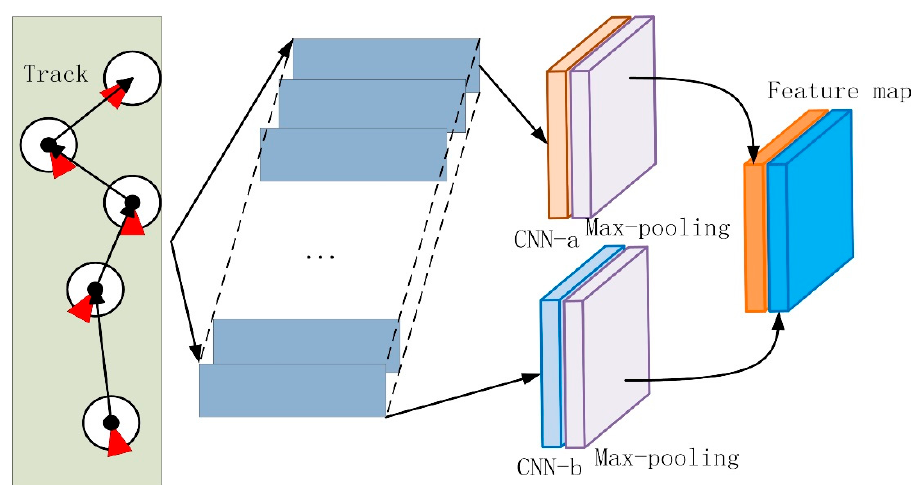
Figure 2. Multi-scale feature extraction and fusion of tracks. The vessel tracks are pre-processed and input to the CNN with different window lengths to obtain the multi-scale feature map, and we subsequently fuse the feature maps in dimension.